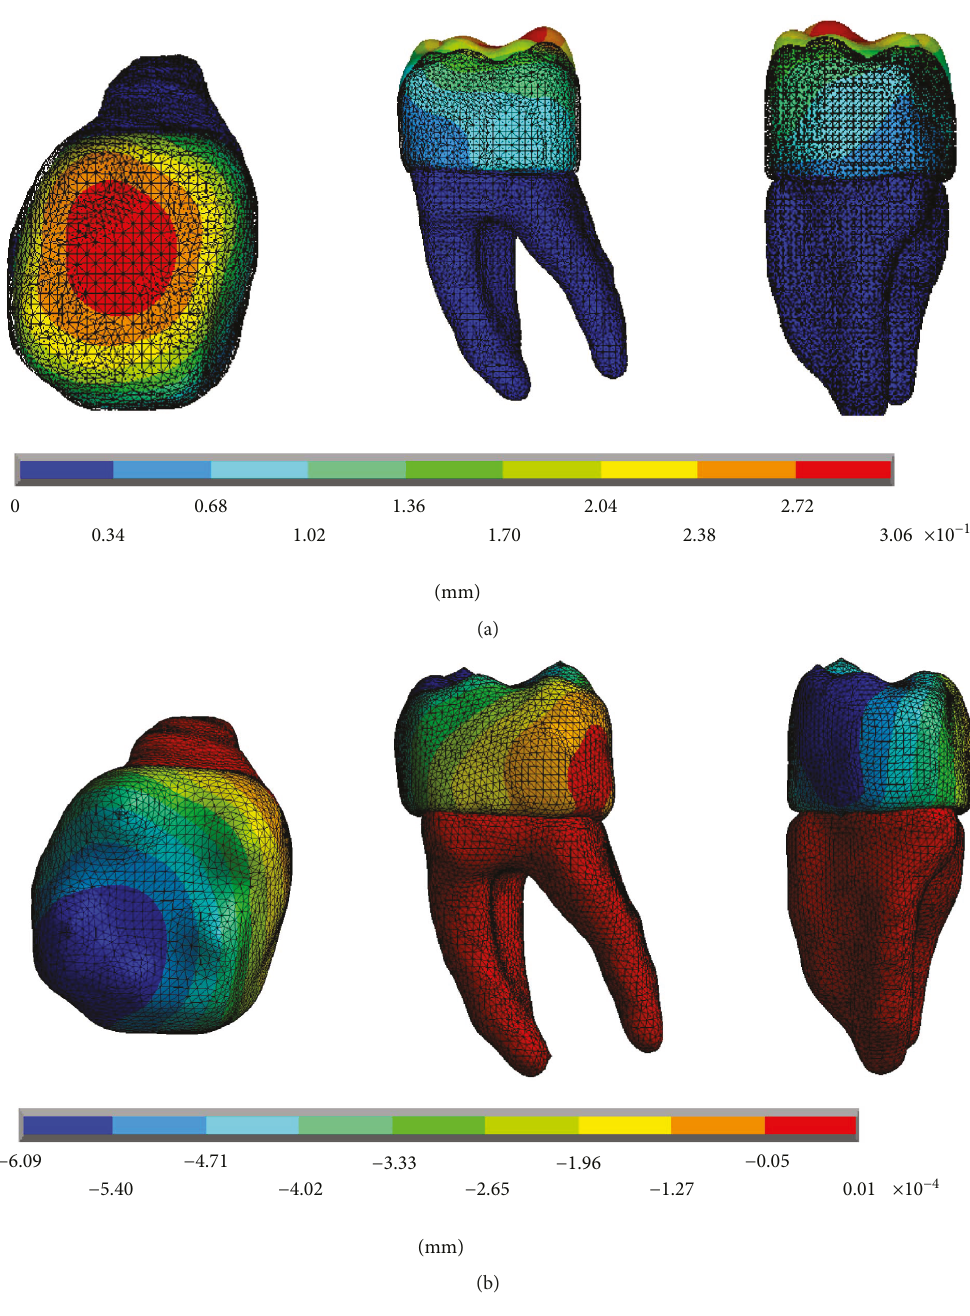
Figure 6: Displacements in the z -axis. (a) Noncontact. (b)